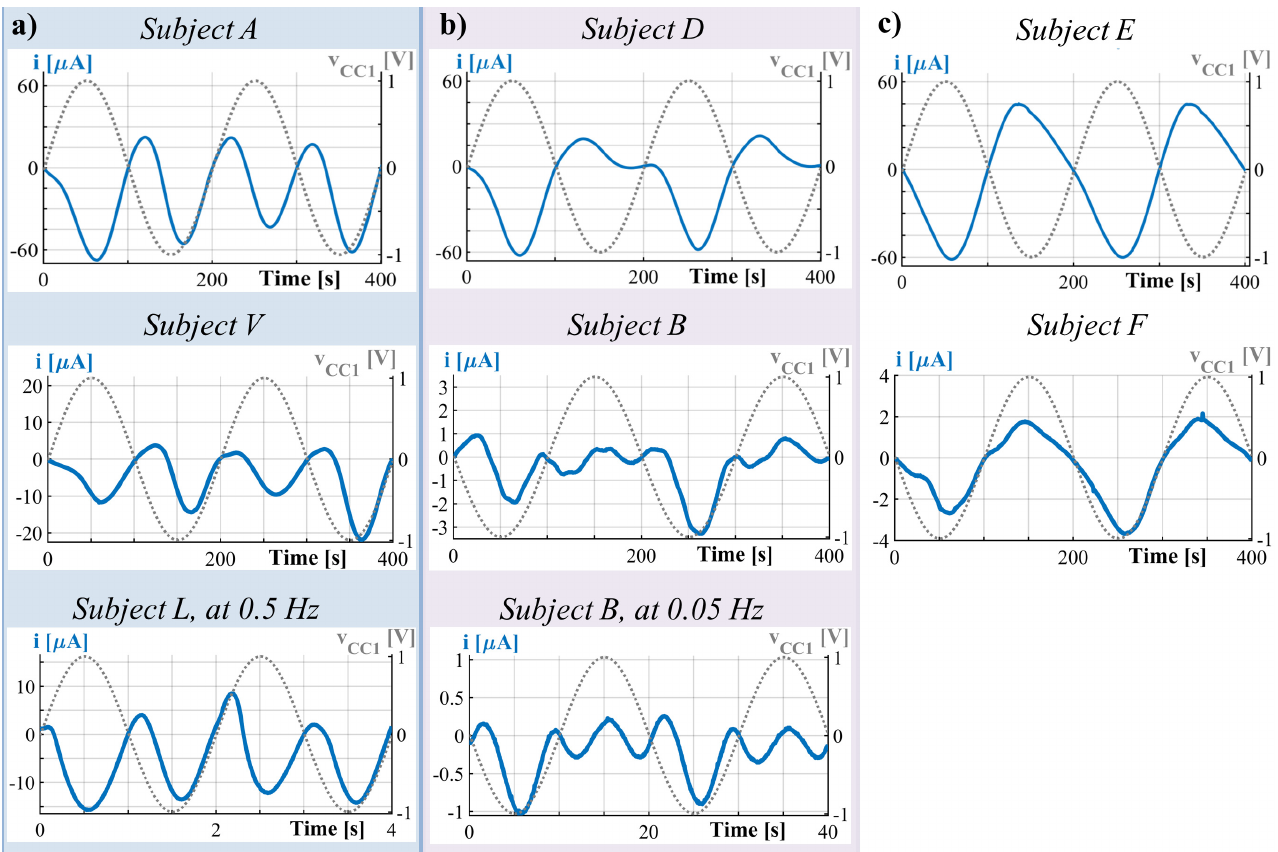
Fig. 2 | Results from several subjects. Applied sinusoidal voltage, v CC1 , (on CC1) and measured current, i , over time. The sign of the amplitude of v CC1 was either 1 V (subject A, for example) or -1 V (subject B, for example) due to randomization and the sign of v CC2 was always opposite. In the top and middle line, the results of the recordings with a voltage frequency of 0.005 Hz are shown. Subject labelling is in accordance with the results presented in [22]. The applied voltages themselves affect the memductance of the skin and consequently the resulting current (non-linear electrical measurement). The memductance changes during the recording and can be different at the beginning of the second period which explains also the differences in the recorded current from period to period. ( a ) Subject A, and V at 0.005 Hz and Subject L at 0.5 Hz. The frequency of the measure is double the frequency of the applied voltages. The measured currents of a total of five subjects (2 out of 12 with the CC1 electrode at the earlobe, 3 out of 16 with the CC1 electrode at the forehead) are comparable when the applied voltage frequency is 0.005 Hz. Two of these subjects show similar results at 0.05 Hz, and one of these two even shows a similar result at 0.5 Hz (subject L). ( b ) Subject D and B at 0.005 Hz and subject B at 0.05 Hz. The measured current has a large magnitude in one half of the period and is more or less cut off during the other half of the period. Six subjects in total (3 out of 12 with the CC1 electrode at earlobe, 3 out of 16 with the CC1 electrode at the forehead) show a similar behavior at a frequency of 0.005 Hz and five out of them show also (more or less) similar behavior at 0.05 Hz. ( c ) Subject E and F. The measured currents are non-linear, but neither half-wave rectification nor frequency doubling is observed. Seventeen subjects in total show similar behavior at 0.005